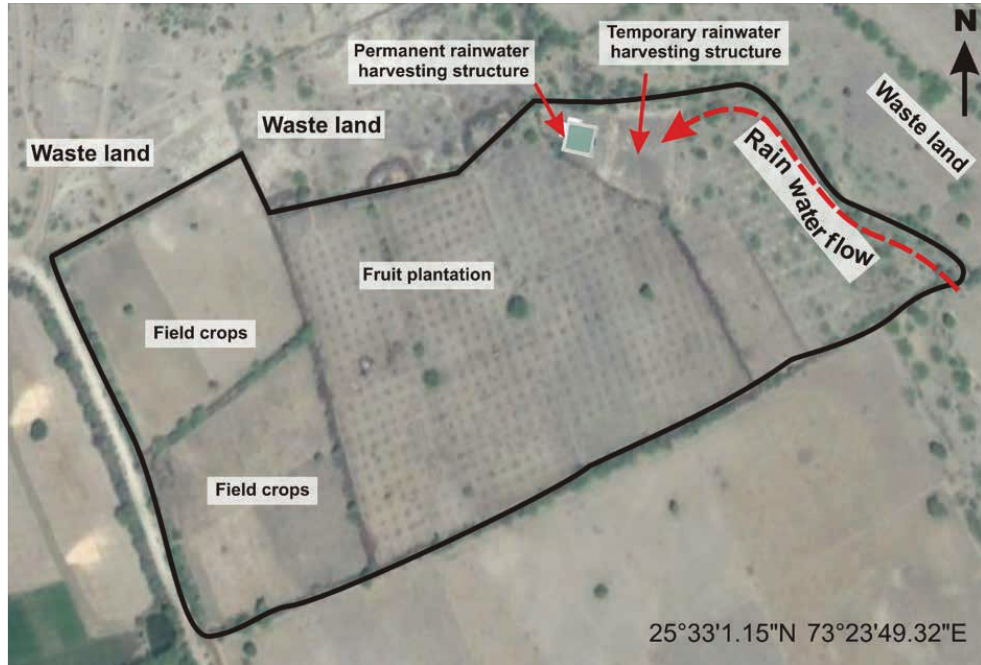
Figure 2: Satellite view of Taju Khan’s